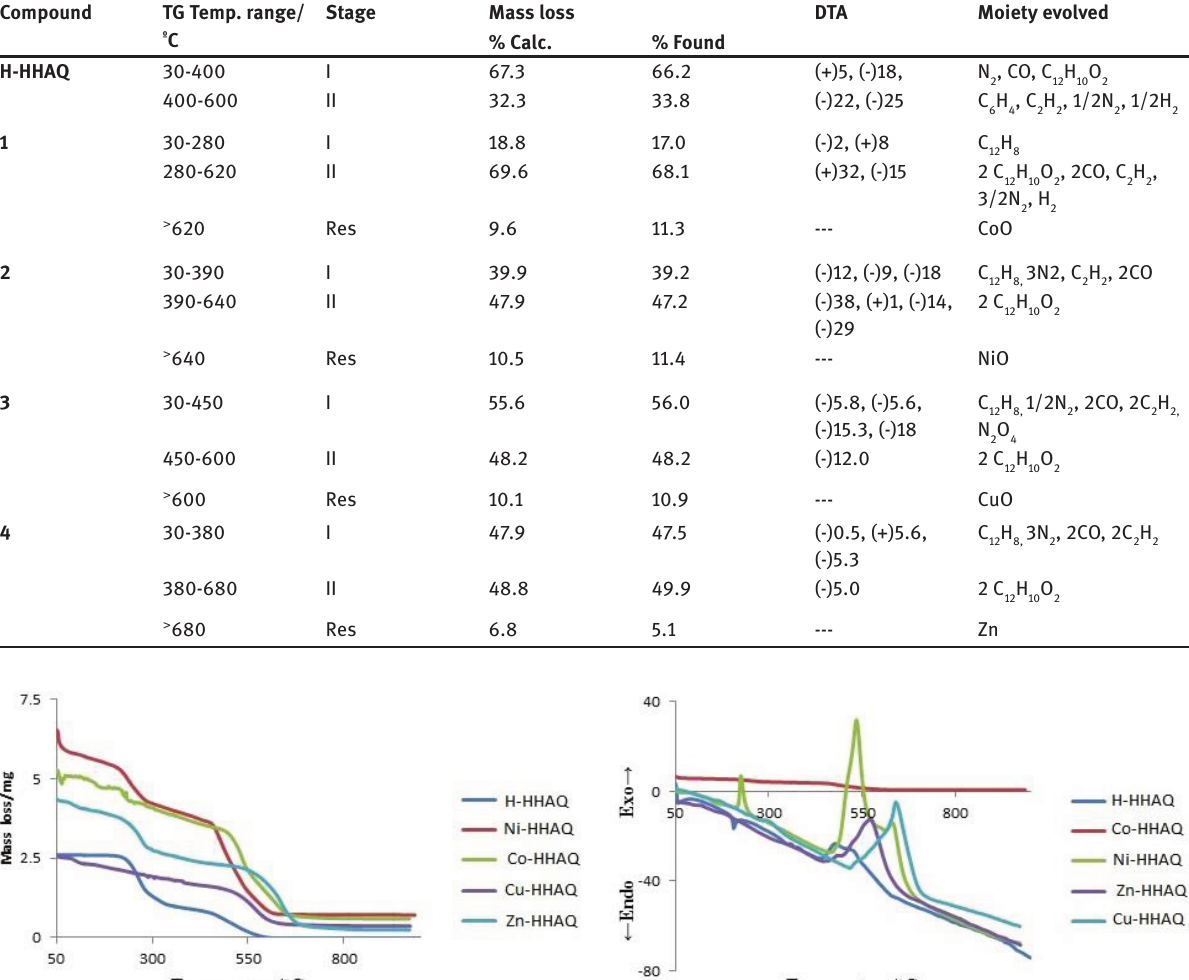
Table 6: Thermo analytical results of H-HHAQ and its complexes. Compound